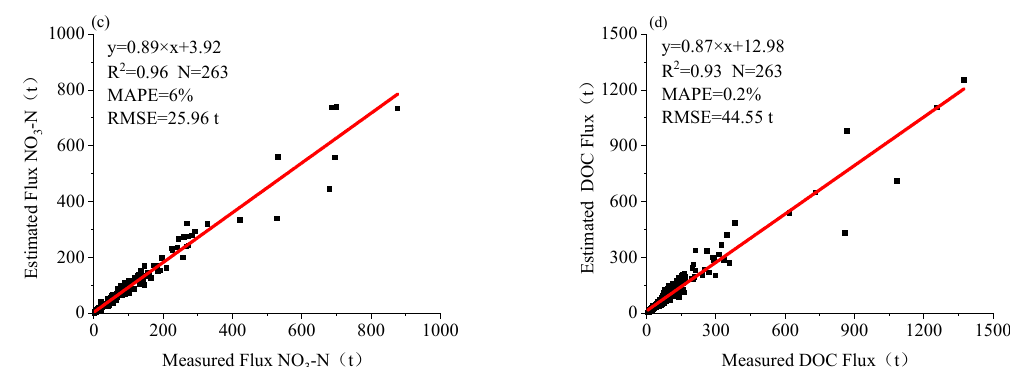
Figure 3. Scatter plots show the nutrient flux between the measurements and estimated values by regression equations. ( a ) TN; ( b ) TP; ( c ) NO 3 -N; ( d ) DOC.